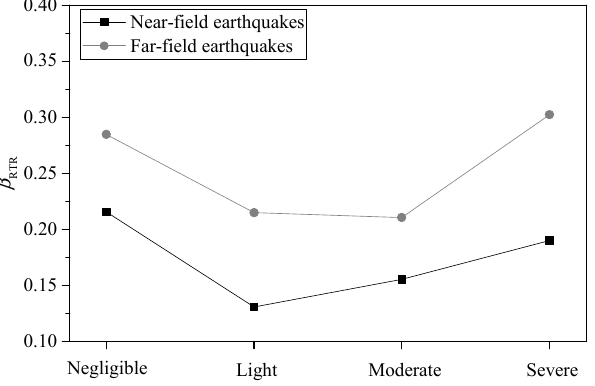
∗ IM that uses the recommended parameters. Figure 16. β that uses the recommended 12 12